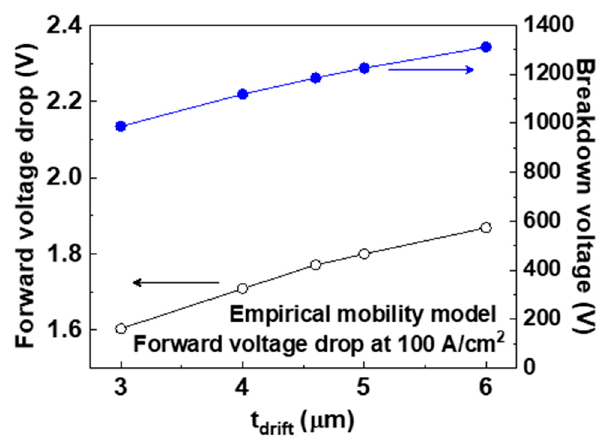
Figure 9. Simulated forward voltage drop at 100 A / cm 2 ( V f ) and breakdown voltage of the p-type diamond pseudo-vertical Schottky barrier diodes (SBDs) with values of t drift of 3.0, 4.0, 4.6, 5.0, and 6.0 µ m. The empirical mobility model used for the forward current–voltage (I–V) characteristics at 300 K.